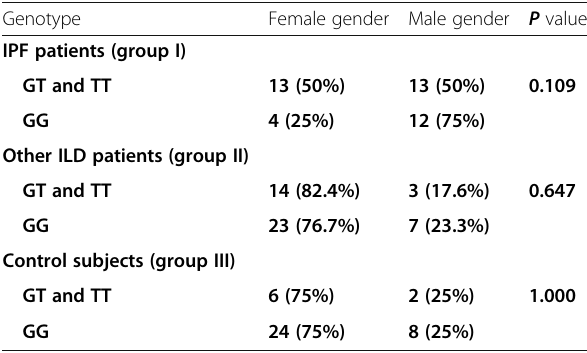
Table 3 The genotypes of MUC5B promoter polymorphism as regards gender among the 3 studied groups Genotype